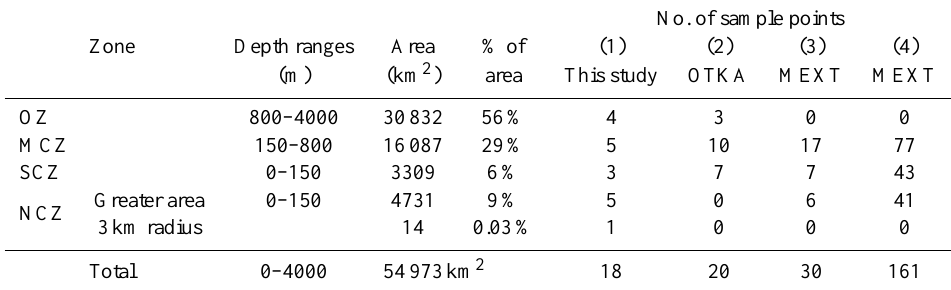
Table 3a. Zonal statistics used for inventory estimates. Cores from group (1) are from this study only. Samples in group (2) were taken from Otasaka and Kato (2014; OTKA). Group (3) includes MEXT cores from February 2012 only, and group (4) contains MEXT cores from (3) plus additional cores from the end of June 2011 through February 2012 (Kusakabe et al., 2013).